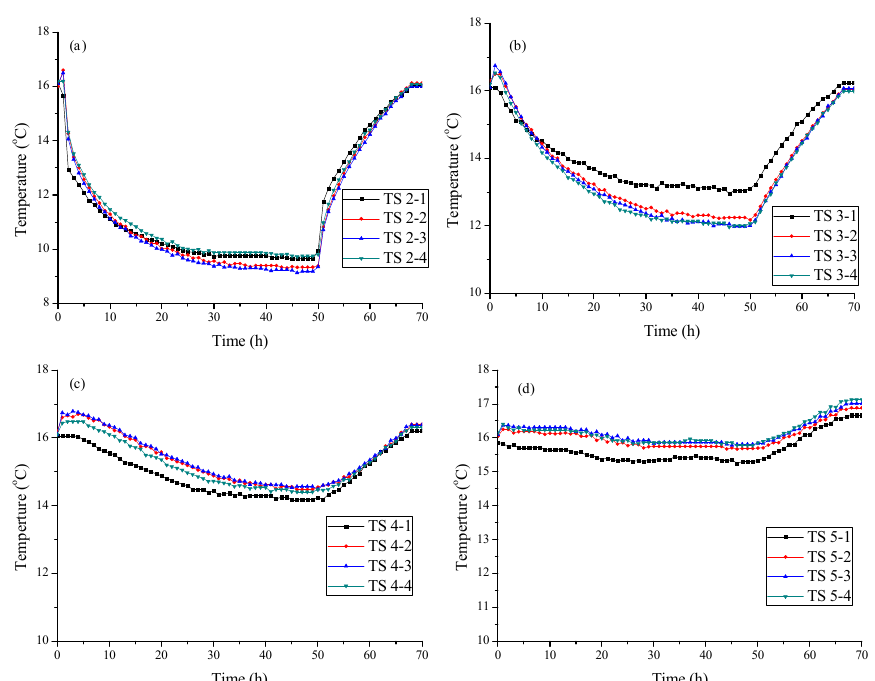
Figure 9. Time-dependent temperature curves of TSs of different distances to UT along each row in the fluid circulation of − 10 °C: ( a ) Array 1 TSs; ( b ) Array 2 TSs; ( c ) Array 3 TSs; ( d ) Array 4 TSs.